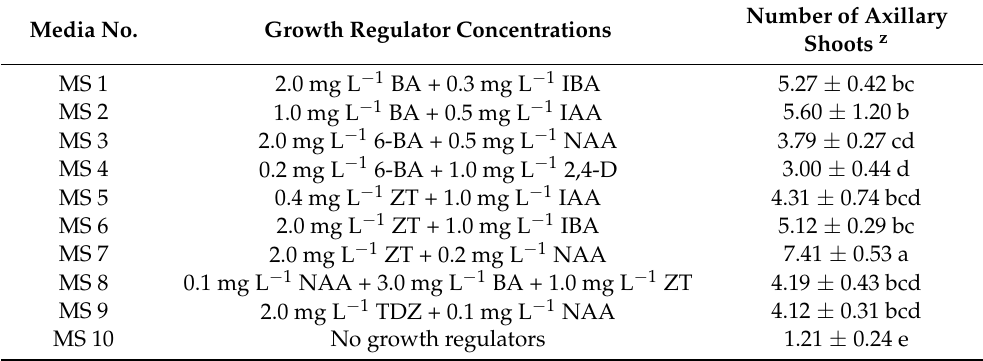
Table 1. Axillary shoots induced from nodal explants of S. portulacastrum after culturing on MS medium supplemented with different growth regulators for eight